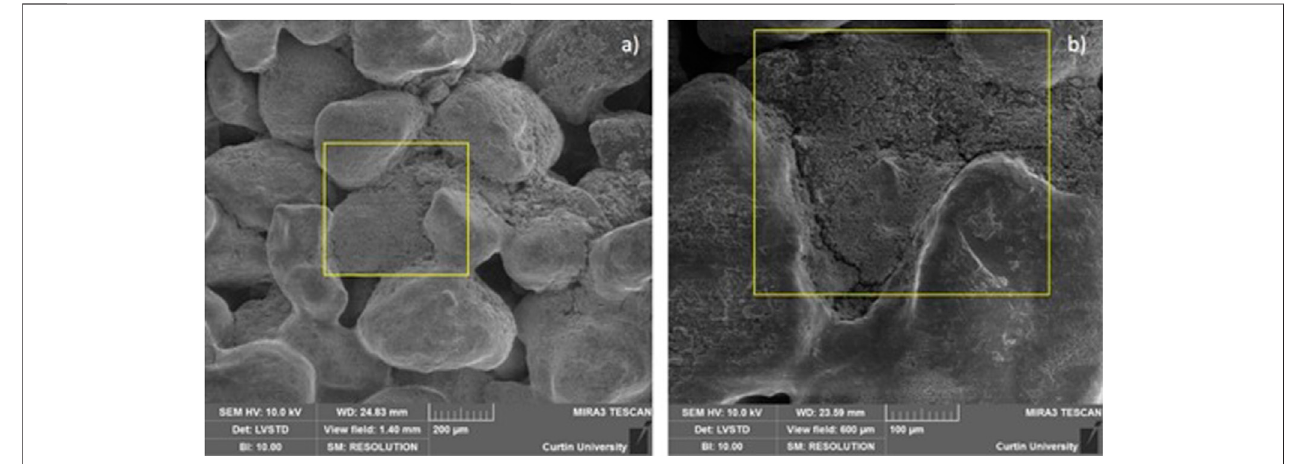
FIGURE 13 | SEM of in-situ biopolymer-clay